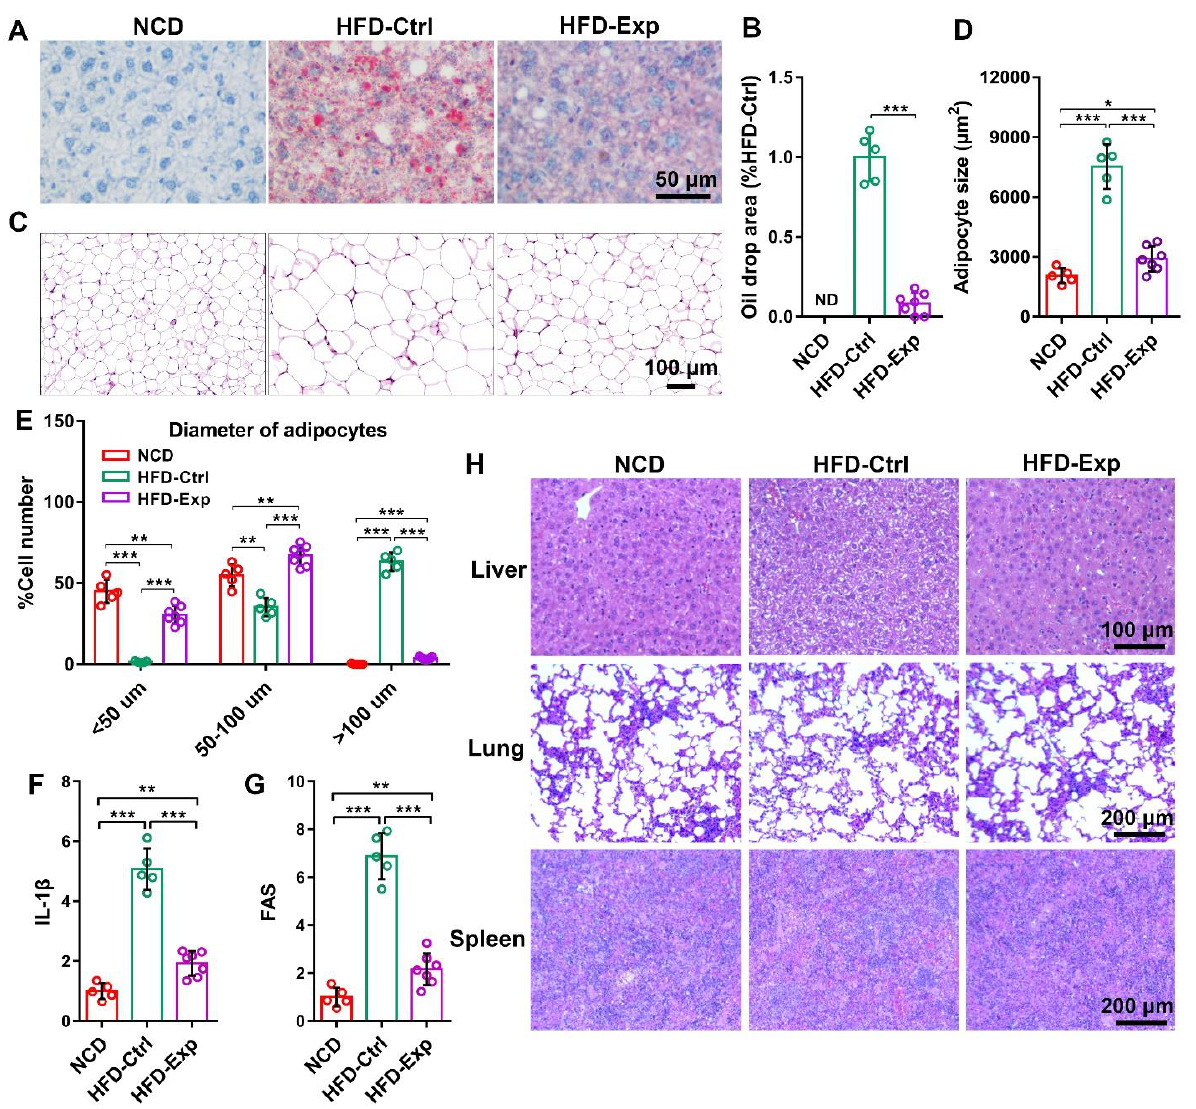
Figure 4. Nontoxic IL-1 β shRNA/yeast inhibited the growth of adipocytes in liver and abdominal adipose. ( A ) Oil-red O staining of liver. ( B ) Percentage of oil drop area in liver. ( C ) H&E staining of abdominal adipose. ( D ) Adipocytes mean area (μm 2 ). ( E ) Quantity statistics of adipocytes in different sizes (maximum diameter of cells, <50 μm, 50–100 μm, >100 μm). The expression of IL- 1β ( F ) and lipid metabolism related gene FAS ( G ) in abdominal adipose. ( H ) H&E staining of liver, lung and spleen. ND (not detected). * p < 0.05, ** p < 0.01, *** p < 0.001 ( n = 5 or 7).